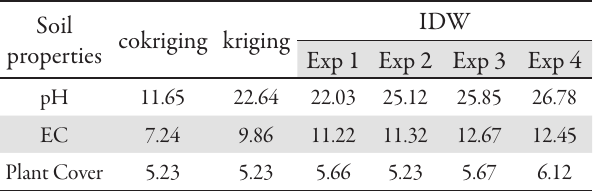
Tab. 8. Results of the interpolation error for estimation of soil properties